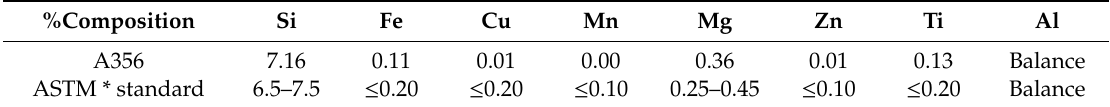
Table 1. Chemical composition of the A356 specimen used in this study